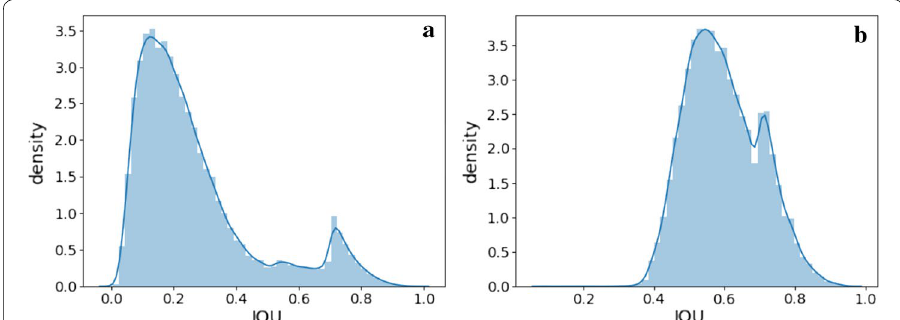
Fig. 3 Distribution of the IOU between ground true bounding boxes and matched anchors: a before anchors optimization, b after